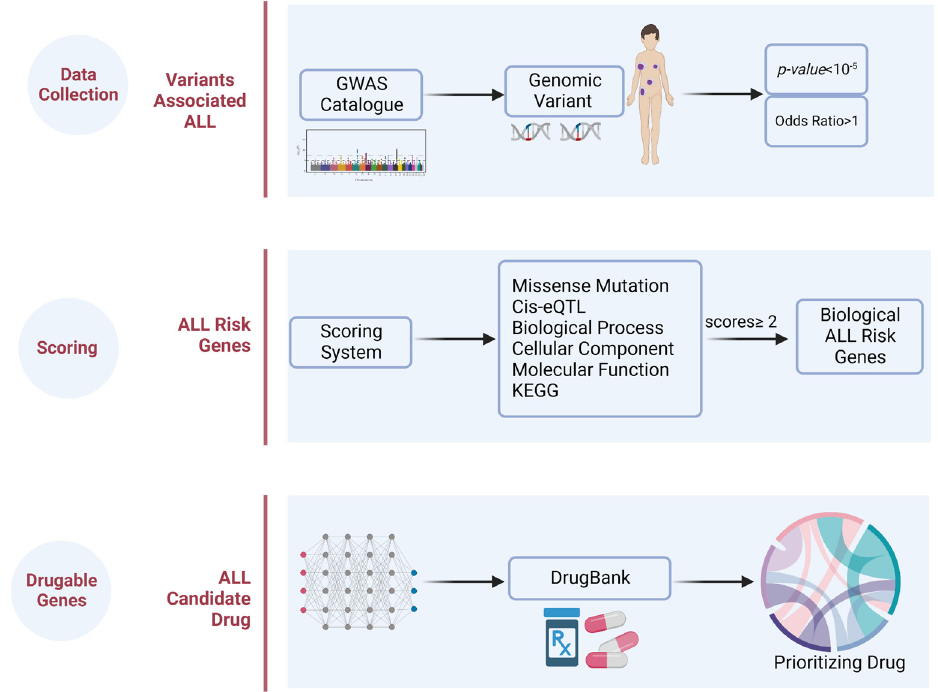
Figure 4. Workflow of the study by leveraging the genomic variants from GWAS and prioritizing it by several functional annotations. Through the genomic variants − driven drug repurposing concept, we finally obtained the drug candidates to be repurposed for ALL according to a drug